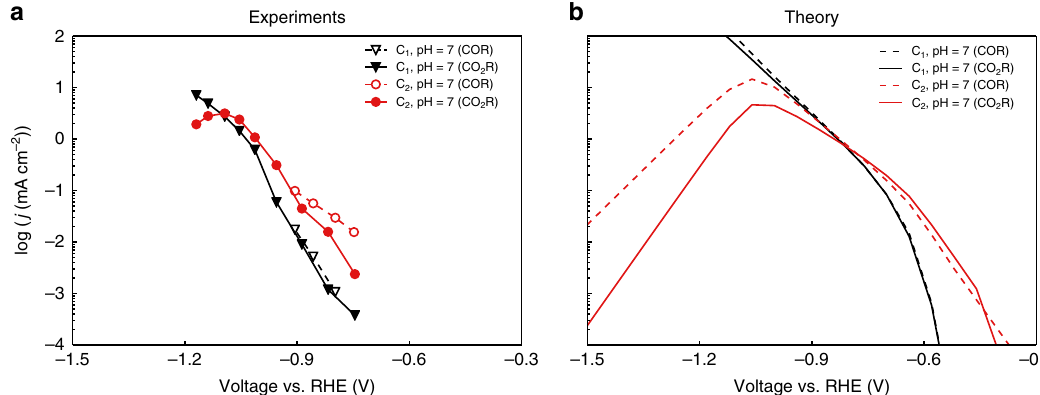
Fig. 5 Comparison of CO and CO 2 R at pH 7. a Measured COR and CO 2 R activities toward C 1 and C 2 at pH = 7. Data are taken from refs. 9,26 . b Predicted COR and CO 2 R polarization curves on Cu(211) at pH = 7